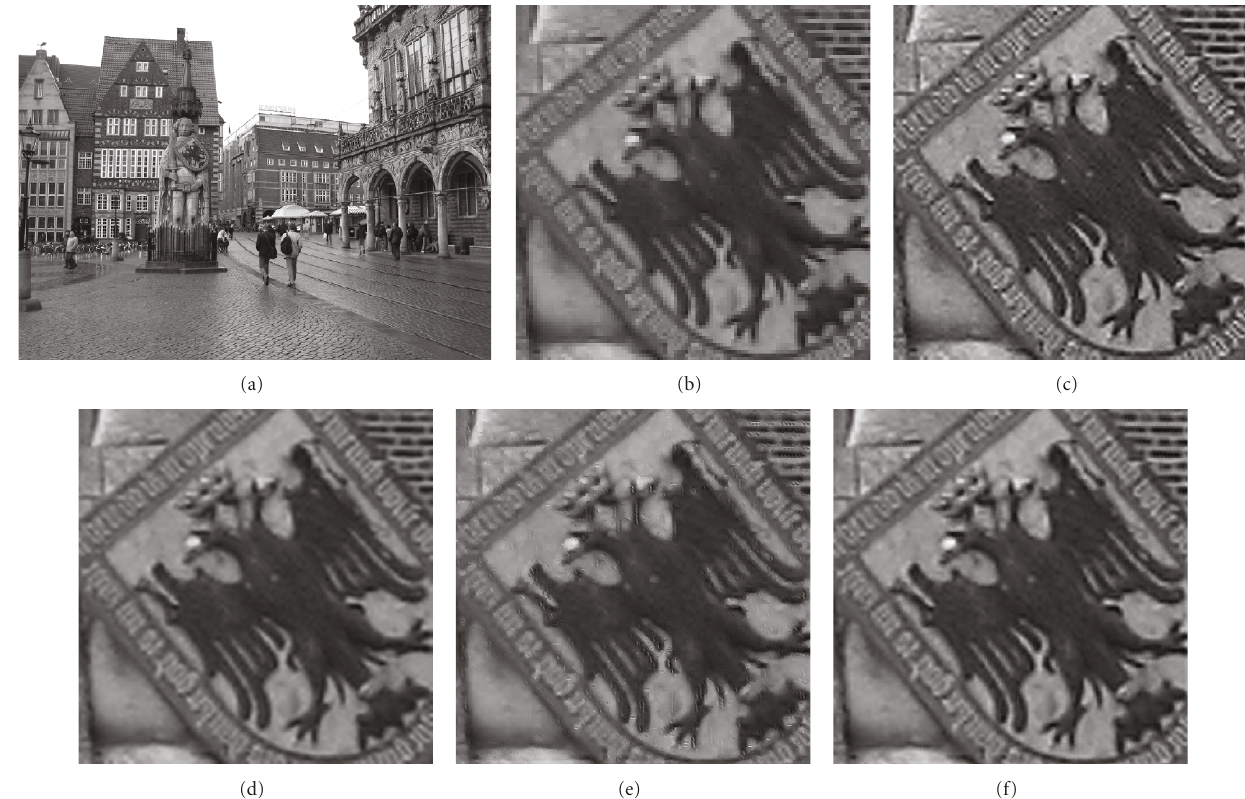
Figure 7: Subjective performance comparison between the proposed method and the conventional methods: (a) test image (1600 × 1200 pixels), (b) LR image (100 × 100 pixels) clipped from (a), (c) HR image estimated by the proposed method, (d) HR image estimated by the interpolation using Lanczos filter, (e) HR image estimated by [10], and (f) HR image estimated by [21]. The obtained results are 400 × 400 pixels, that is, the magnification factor is set to